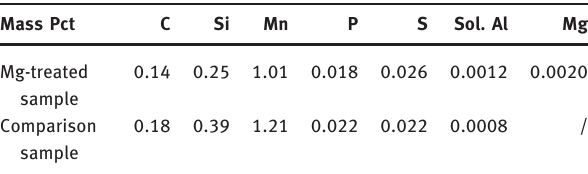
Table 1: Chemical composition of steel samples (mass percentage). Mass Pct C Si Mn P S Sol. Al Mg Mg-treated sample Comparison